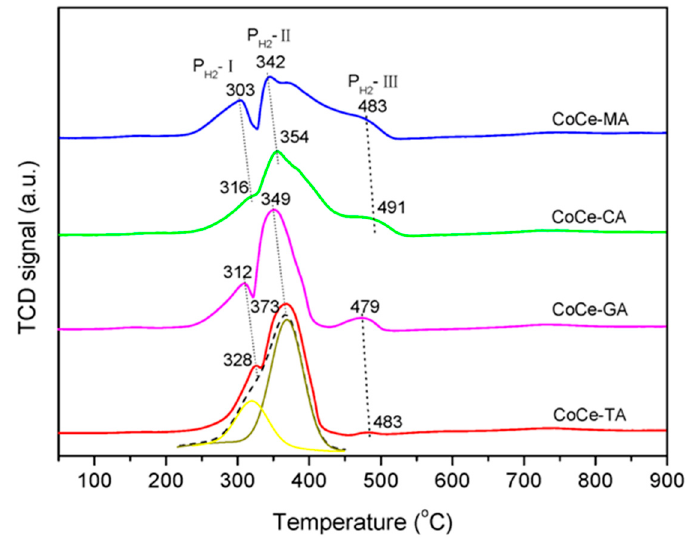
Figure 6. H 2 –TPR profiles of the CoCe–X catalysts. Table 5. H 2 consumption and catalytic activities of the CoCe–X